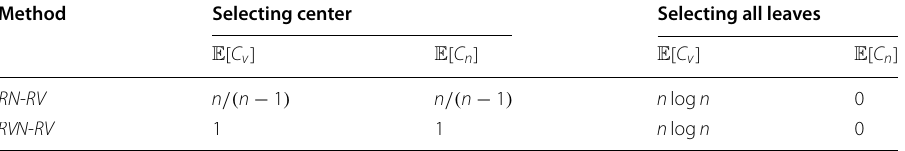
Table 4 An analysis of costs C v and C n in a star graph of n vertices for two‑phase